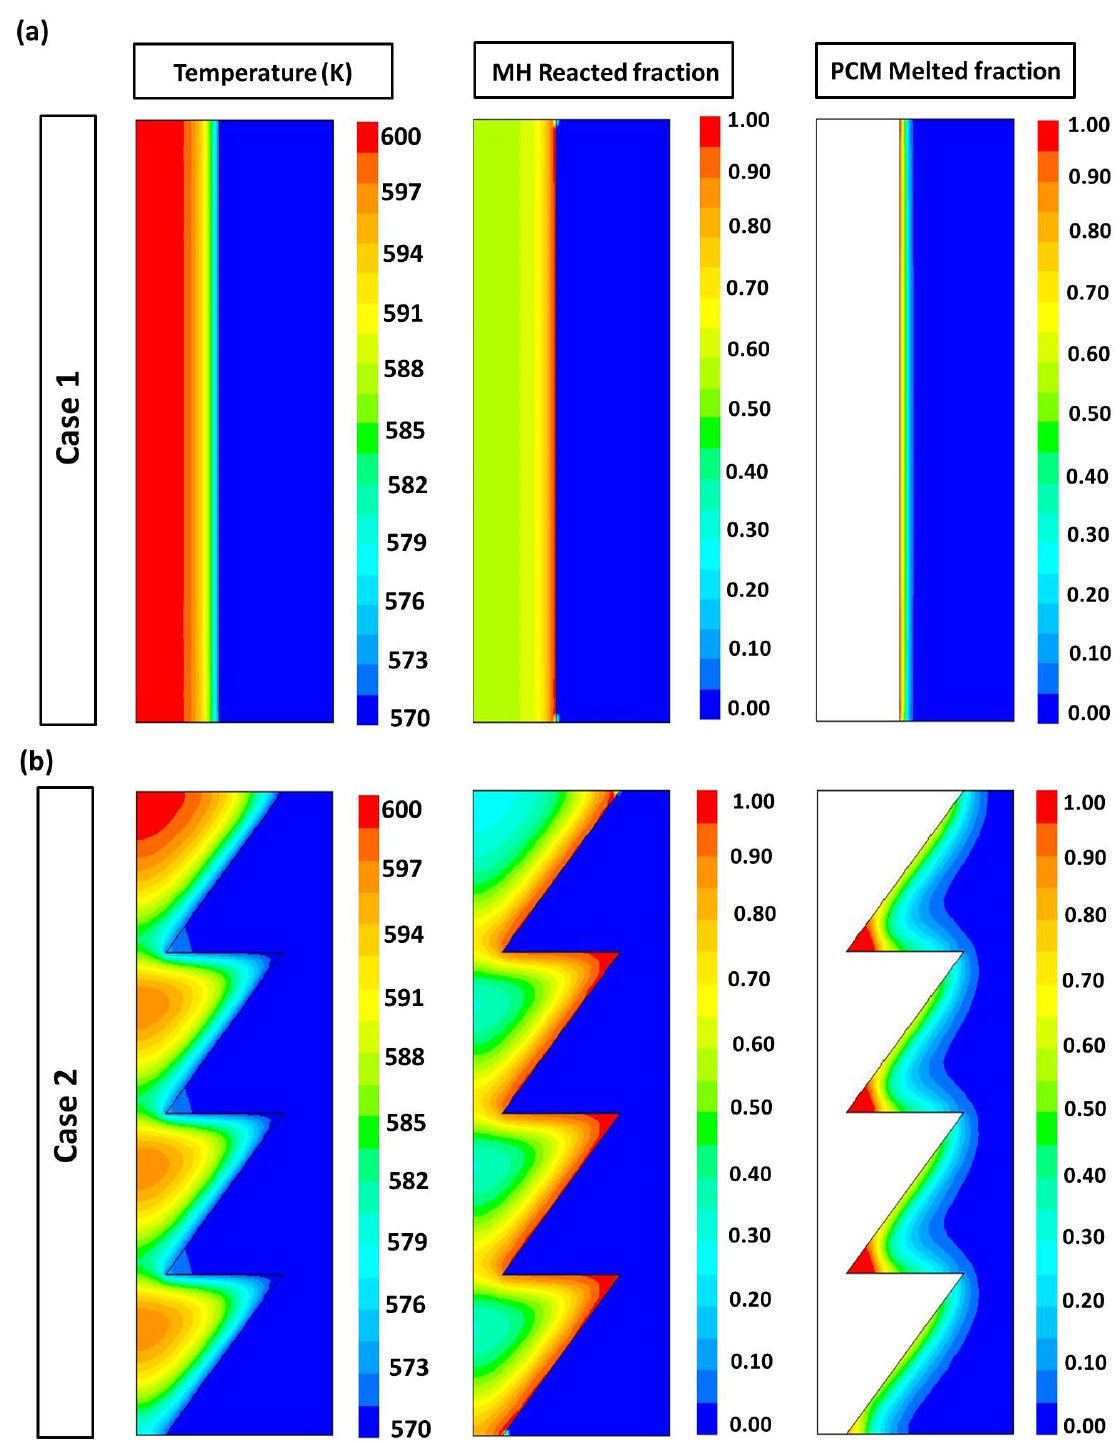
Figure 8. Contours of the temperature, the reacted fraction and the PCM melted fraction within two kinds of MH-PCM stacked disk configurations: ( a ) cylindrical MH bed and ( b ) truncated conical MH bed.